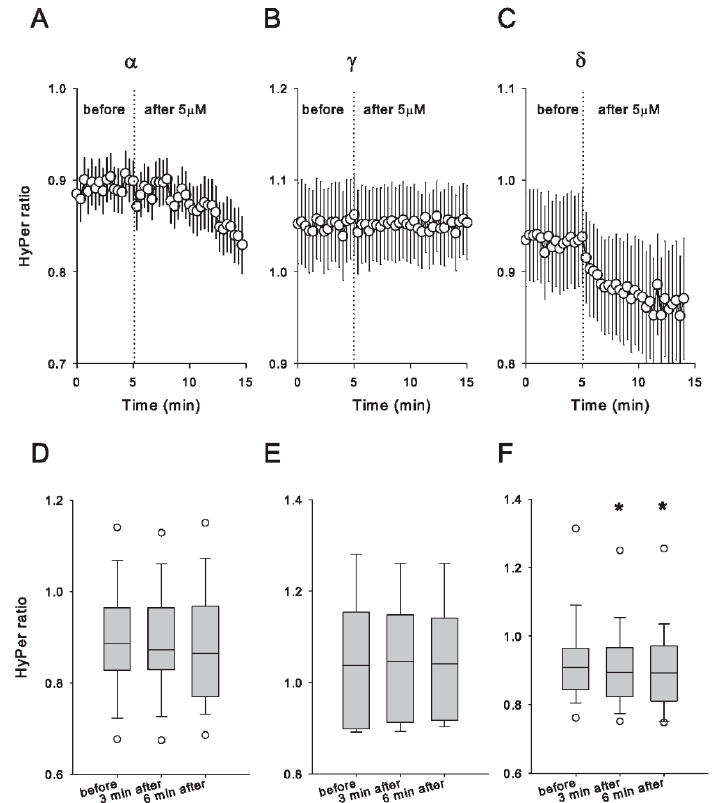
Figure 3. Acute effects of tocopherol isomers on HyPer baseline signal in Caco-2 cells. Caco-2 cells were transduced with the HyPer biosensor. Two days after, HyPer imaging took place. Five micromoles of α ( A ), γ ( B ) and δ ( C ) isomers was applied as indicated by dotted lines in the graphs. Data correspond to the mean ± SE of at least 11 cells from three independent experiments. For each single-cell recording, HyPer ratio values were obtained before and after isomer addition (3 and 6 min) of α - ( D ), γ - ( E ) and δ - ( F ) tocopherol. The lines in the middle of the boxes correspond to the median of the data group. Open circles ( ○ ) correspond to potential outliers. Asterisks (*) mean significant differences between groups according to RM-ANOVA against the control group (Dunn’s method).